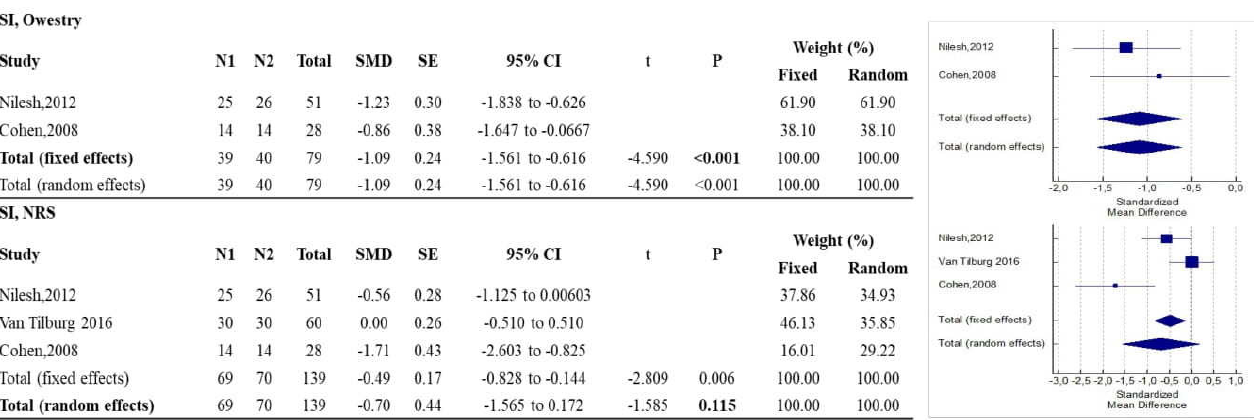
Figure 2. Forest plots showing the intervention effect on the shoulder VAS and Spady outcomes. The use of fixed or random effects (bold) is chosen based on the results of the Higgins’ heterogeneity test. Note: N1 = no. of patients in the intervention group; N2 = no. of patients in the control group; SMD = standardized mean difference; CI = confidence interval.